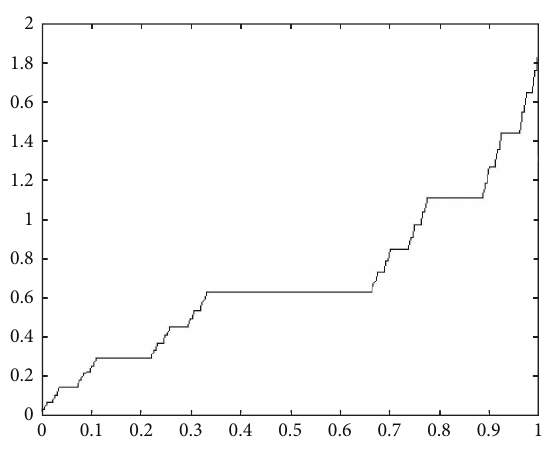
Figure 5: Graph of sinh 𝛼 𝑥 𝛼 for 𝛼 = ln 2/ ln 3 .